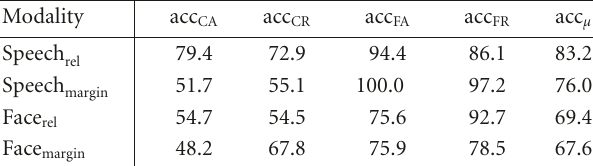
Table 2: Decision reliability classification accuracy. All results are in percent.